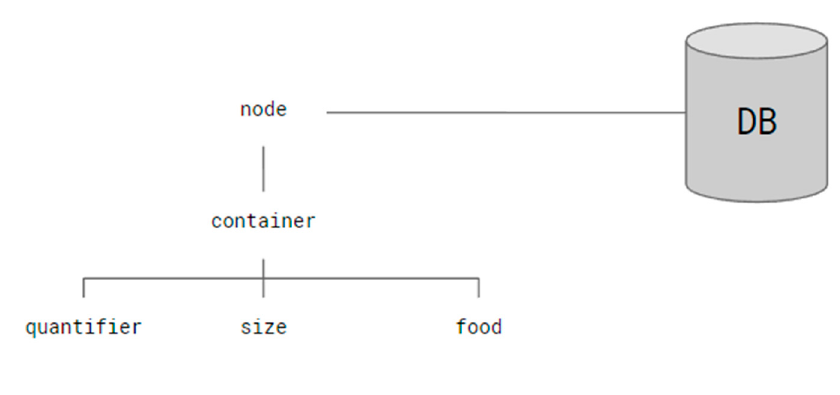
Figure 4. Nutrients calculus